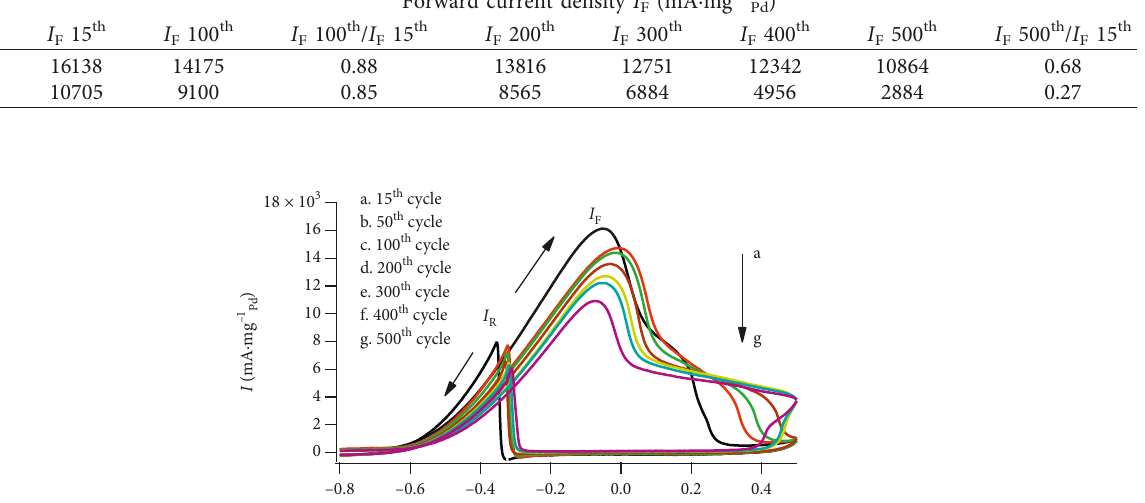
2 H 5 OH 1 M) solution at a scan rate of